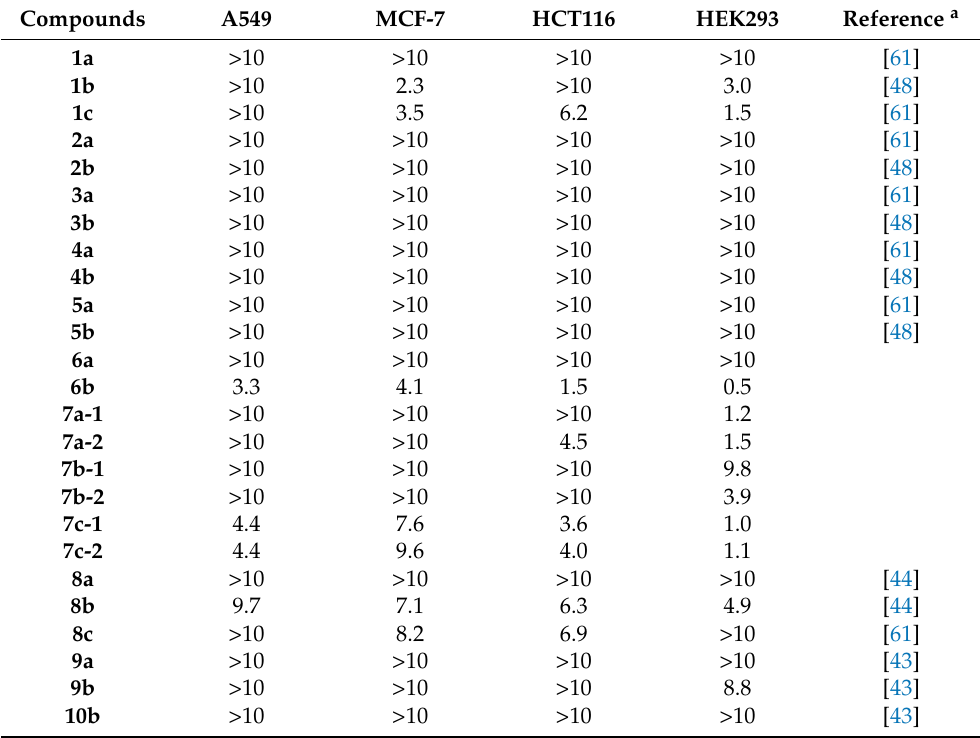
Table 1. IC 50 values (in µ M) of complexes 1–10 towards A549, MCF-7 and HCT116 cancer cell lines and HEK293 healthy human embryonic kidney cells.